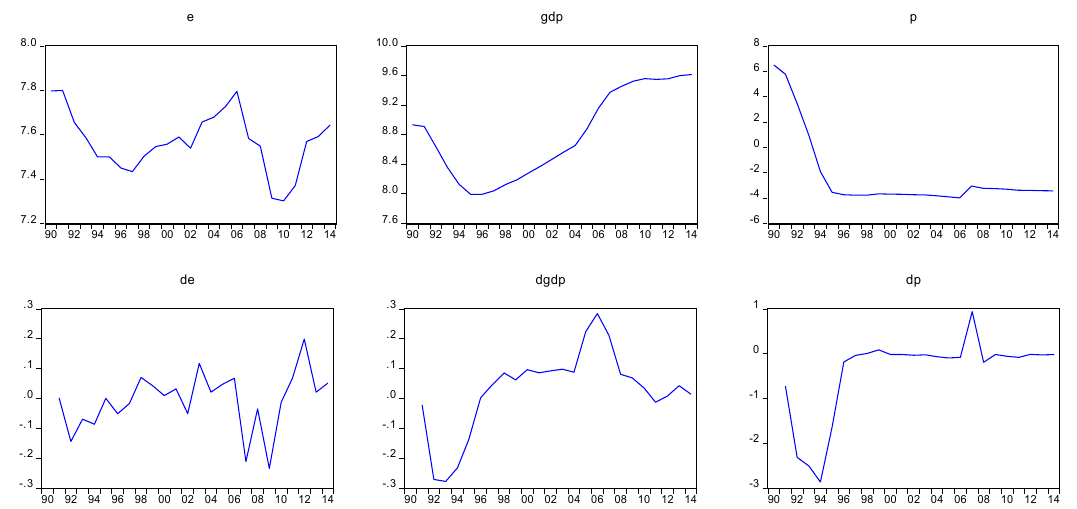
Figure 1. Graphs of the logarithmic forms of the variables and their growth rates.